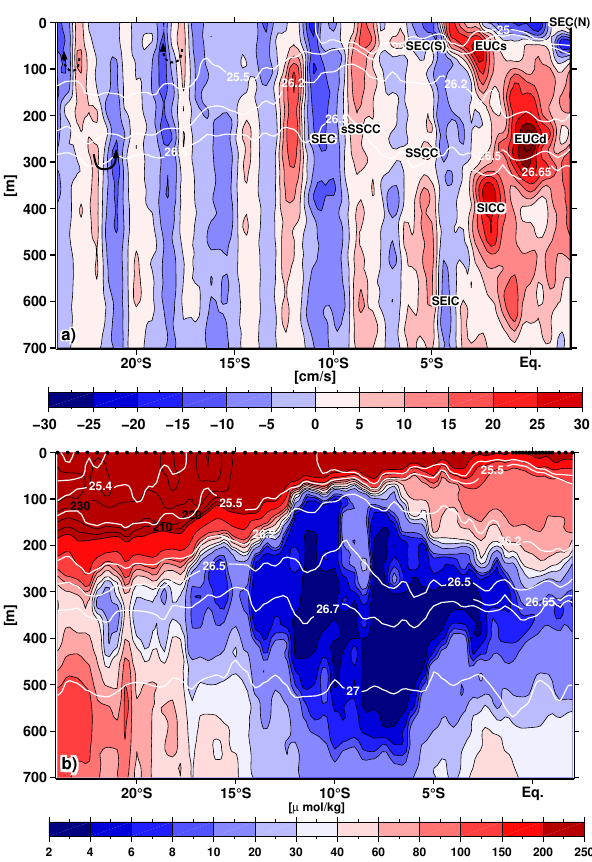
Figure 2. (a) Zonal velocity distribution in cms − 1 (positive east- ward) along about 86 ◦ W between 2 ◦ N and 24 ◦ S from the ship- board ADCP velocity data measured 1 to 13 November 2012. See text for indicated current bands. Some selected isopycnals are in- cluded as white lines. Cyclonic features at the southern part of the section are marked as dashed black arrows, an anticyclonic feature as solid black arrow. (b) Oxygen distribution in µmolkg − 1 (contour interval 10µmolkg − 1 and the 235µmolkg − 1 contour) with isopyc- nals as in (a) plus some additional isopycnals. CTD station locations are marked by black dots at the